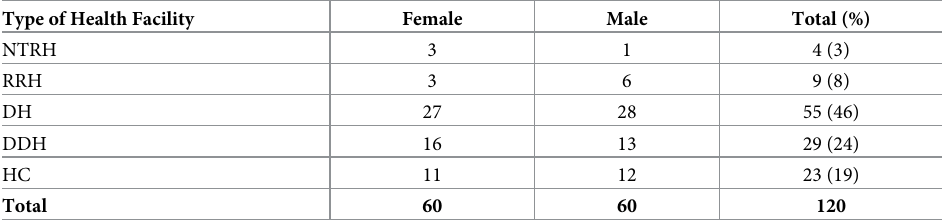
Table 2. Number of study participants for each type of health